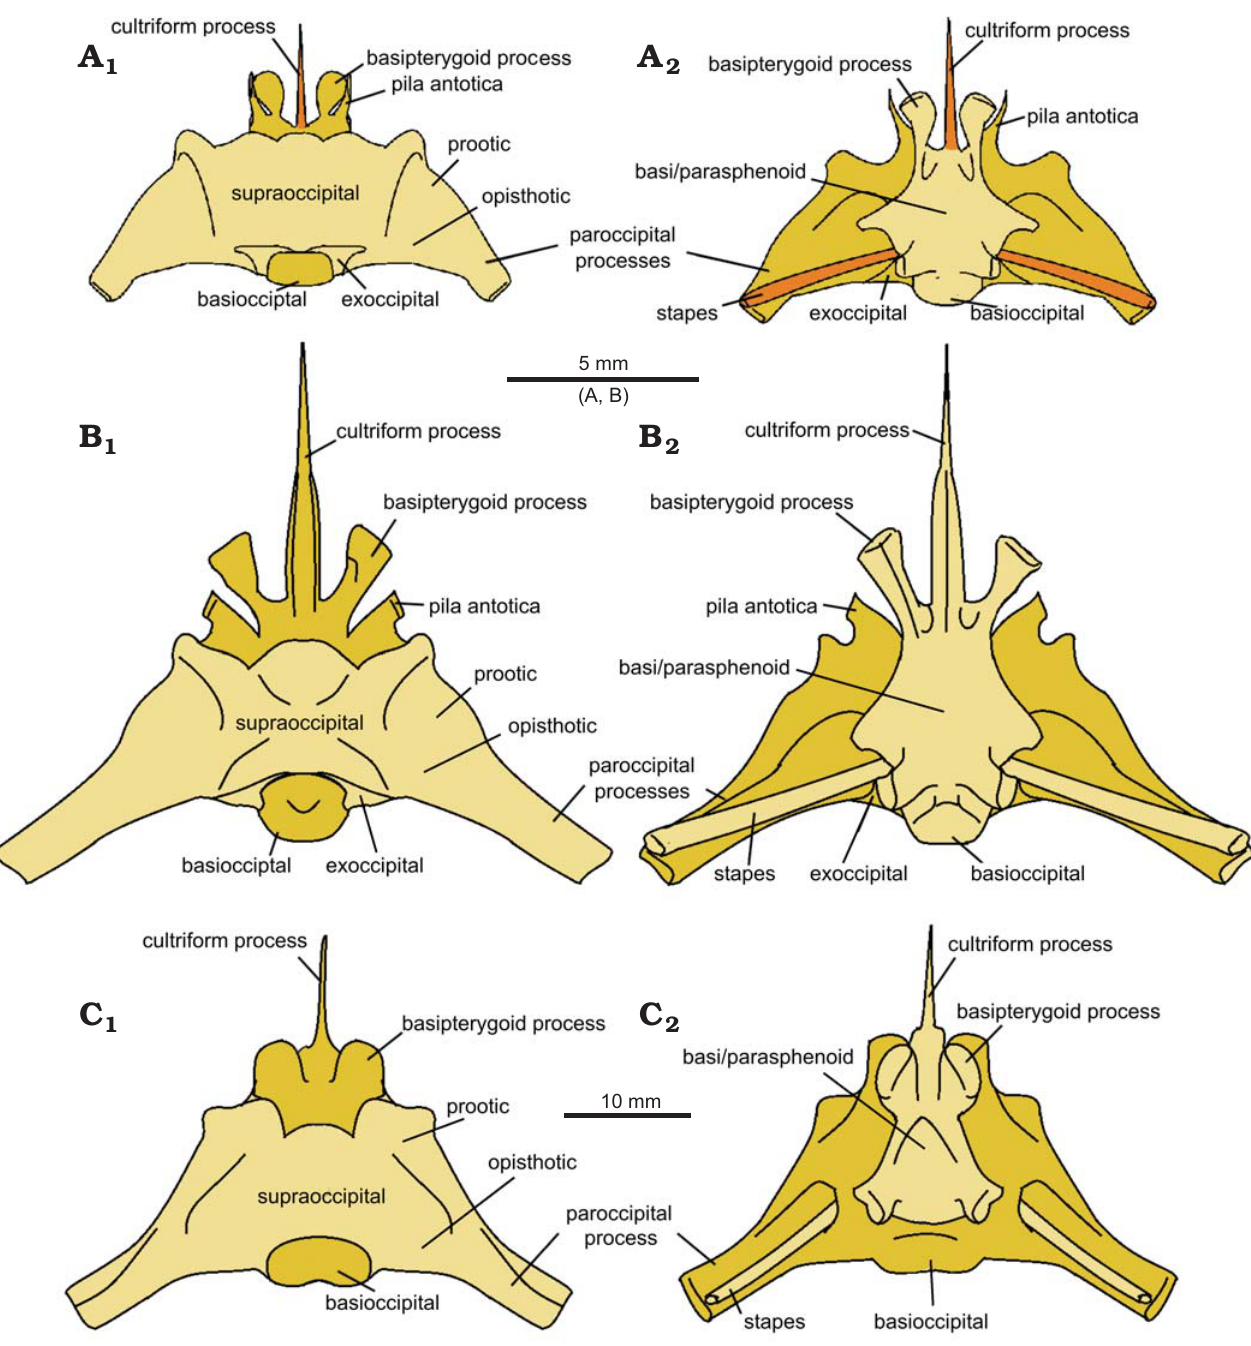
Fig. 13. The reconstructed braincases of lepidosaur rynchocephalians. A . Clevosaurus cambrica Keeble, Whiteside, and Benton, 2018. B . Clevosaurus hudsoni Swinton, 1939. C . Sphenodon punctatus (from Maisano 2001). In dorsal (A 1 –C 1 ) and ventral (A 2 –C 2 ) views. Bones types that are absent in their respective datasets are highlighted in